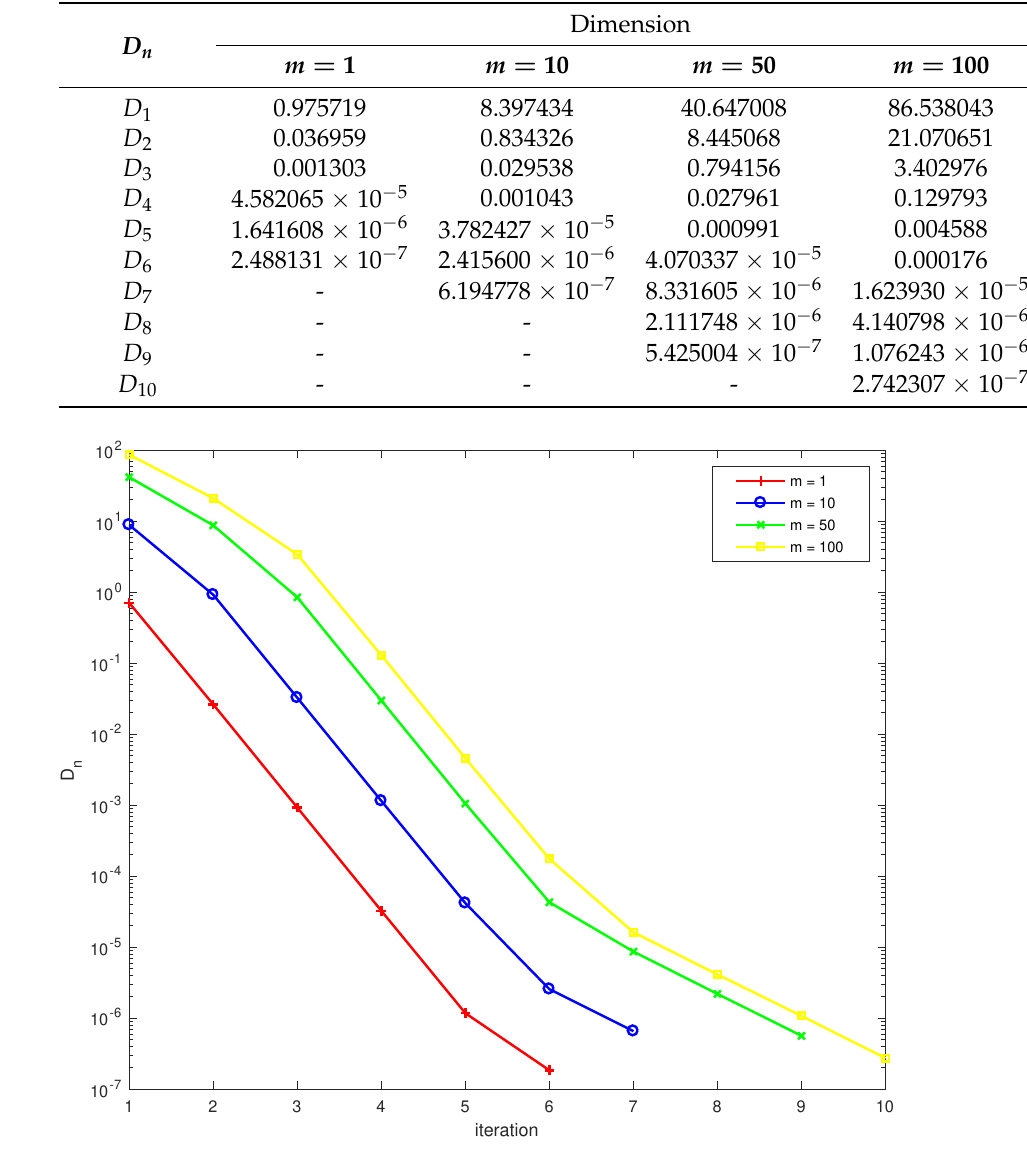
Figure 3. Numerical behavior of { D n } for Example